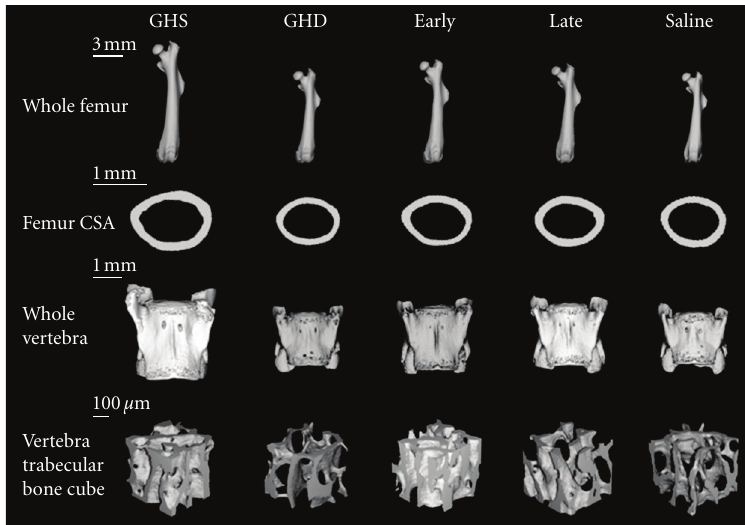
Figure 2: Bone macrostructural results. From top to bottom, the rows display the whole femur, the femur cross-section (CSA), the whole vertebra, and cubes of vertebral trabecular bone. For the whole femur, the animal with the median femoral length in each group is displayed, and this same animal’s femur cross-section (at the shaft midpoint) is shown in the second row. For the whole vertebra, the mouse with the median vertebral body height in each group is shown, and the animal with the median BV/TV in each group is depicted in the bottom row. GH su ffi cient (GHS), GH deficient (GHD), early treatment (early; daily GH injections from age 21 to 60 days), late treatment (late; daily GH injections from age 35 to 60 days), and saline control (Saline; daily saline injections from age 21 to 60